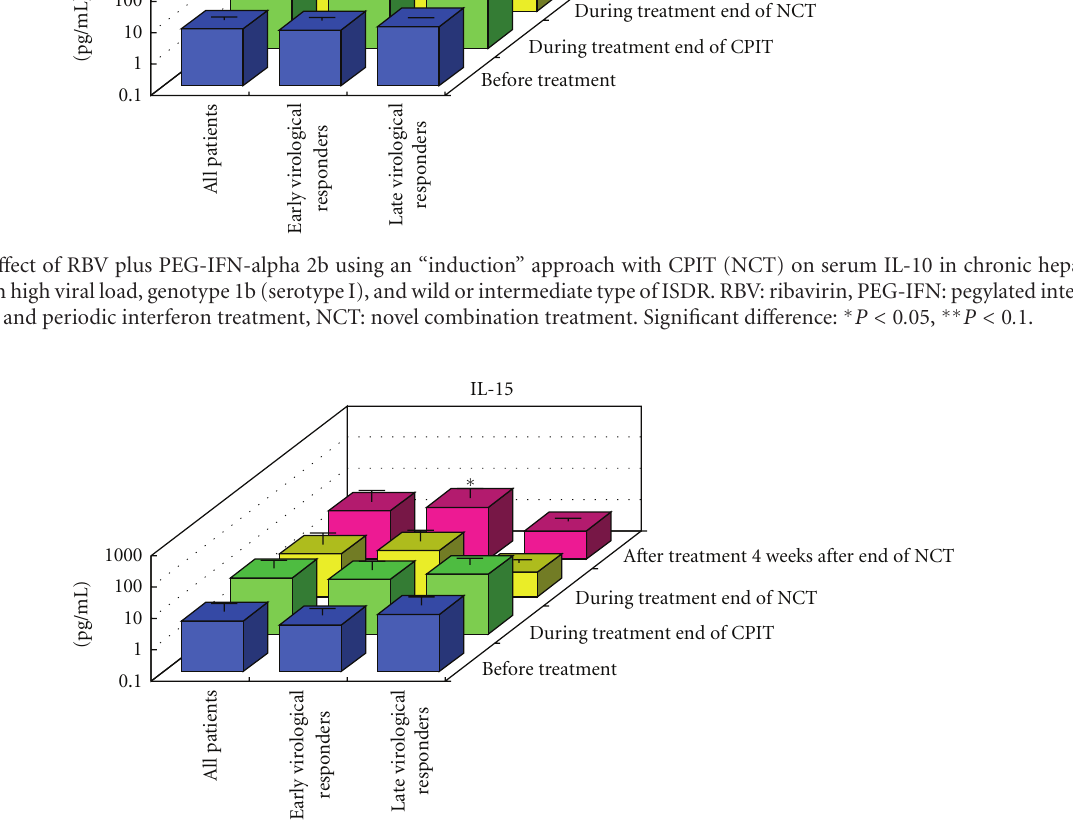
Figure 8: E ff ect of RBV plus PEG-IFN-alpha 2b using an “induction” approach with CPIT (NCT) on serum IL-15 in chronic hepatitis C patients with high viral load, genotype 1b (serotype I), and wild or intermediate type of ISDR. RBV: ribavirin, PEG-IFN: pegylated interferon, CPIT: cyclic and periodic interferon treatment, NCT: novel combination treatment. Significant di ff erence: ∗ P < 0 . 05, ∗∗ P < 0 .